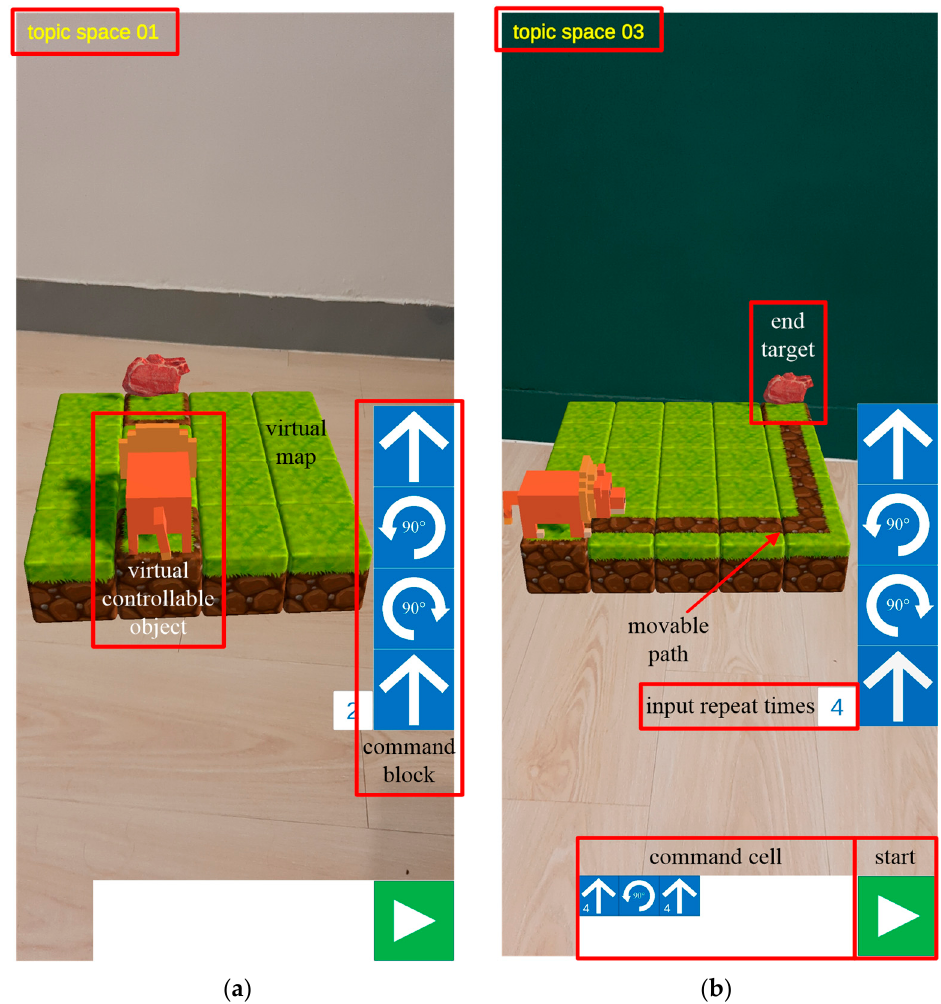
Figure 3. ( a ) Phone screen after opening topic 1; ( b ) phone screen after programming topic 3.